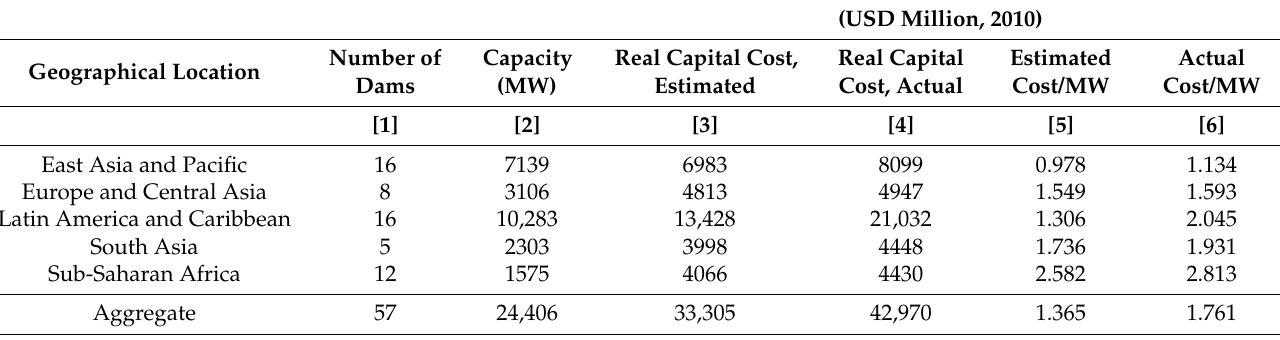
Table 2. Summary of data by